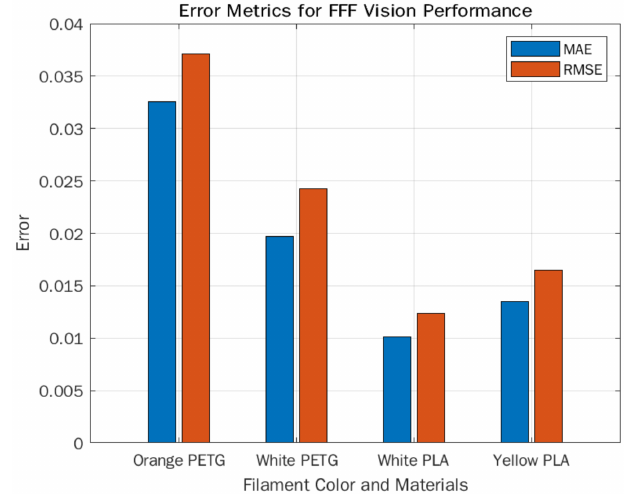
Figure A2. Mean Absolute Error (MAE) and Root Mean Square Error (RMSE) metrics for performance evaluation of FFF vision for different colored filaments and